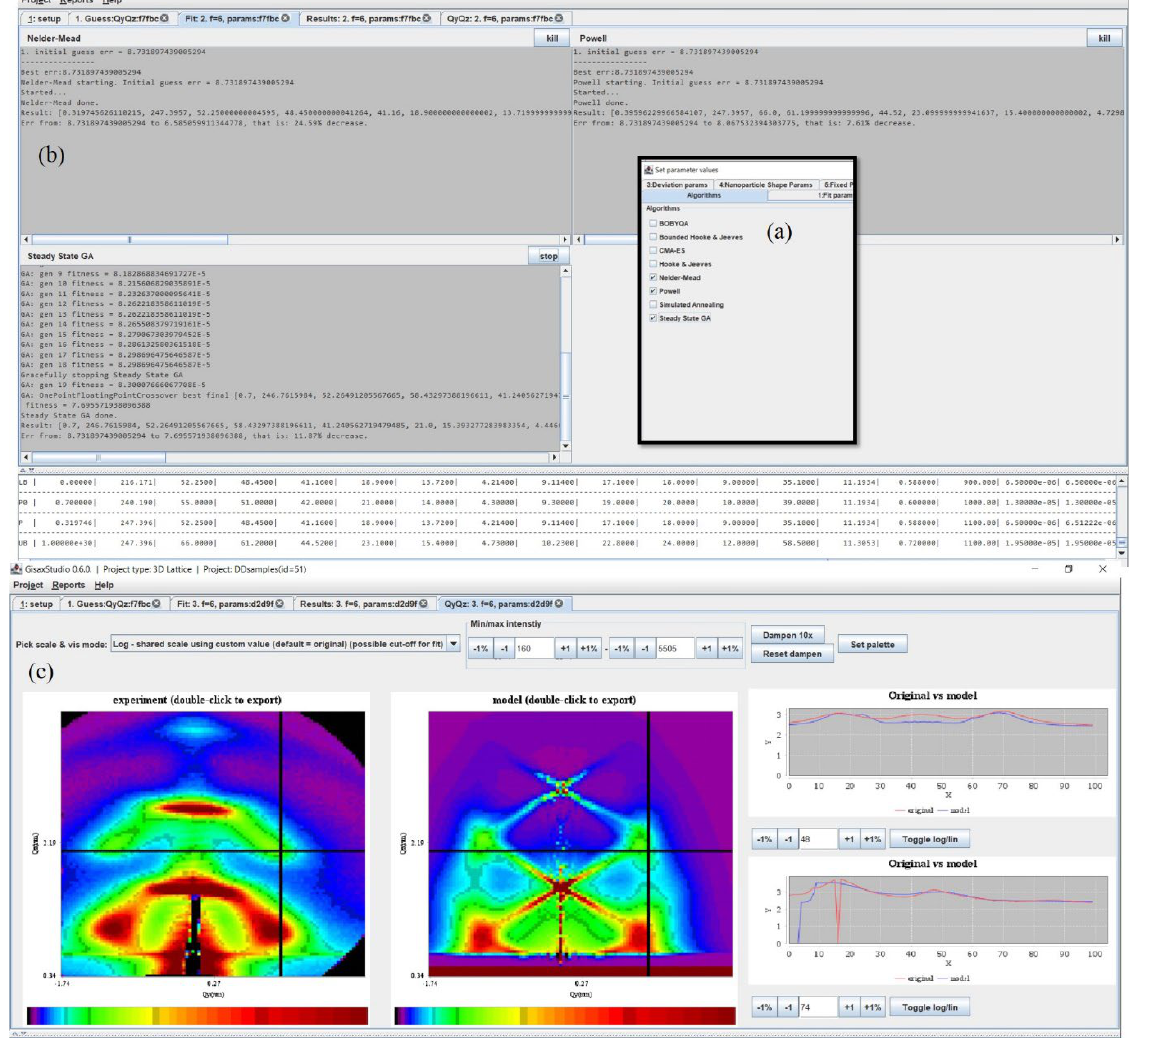
Figure 9. Tabs related to the fitting of the 2D GISAXS map. ( a ) The window with fitting parameters, including the same parameters as in Vis guess option and an additional Algorithms tab that enables the choice of the fitting algorithms. ( b ) Window that appears after starting of the fit, showing its progress. After the fitting is finished, the parameters are shown in the window at the bottom. ( c ) Results of the fitting process, including the original and simulated GISAXS map using the best-fit parameters, along with the line profiles at the right.